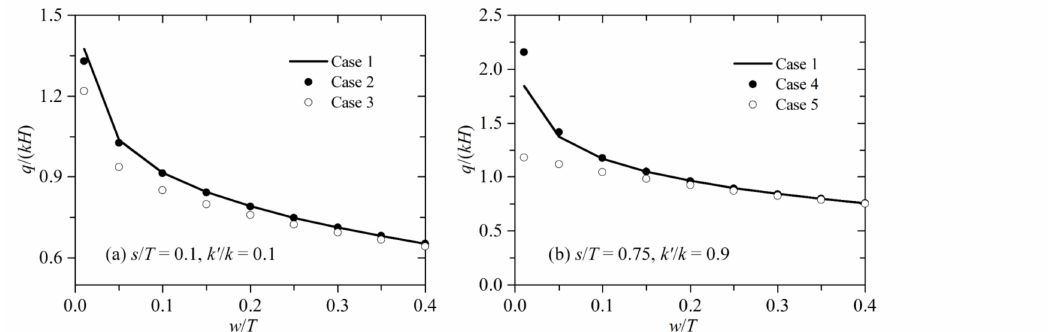
Figure 7. Calculation results of the normalized flow rate when ( a ) s / T = 0.1, k’ / k = 0.1 and ( b ) s / T = 0.75, k’ / k =